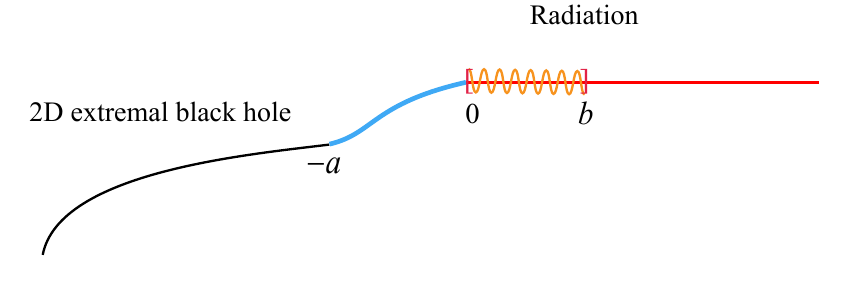
Figure 17 . An illustration for the interval of 2D extremal black